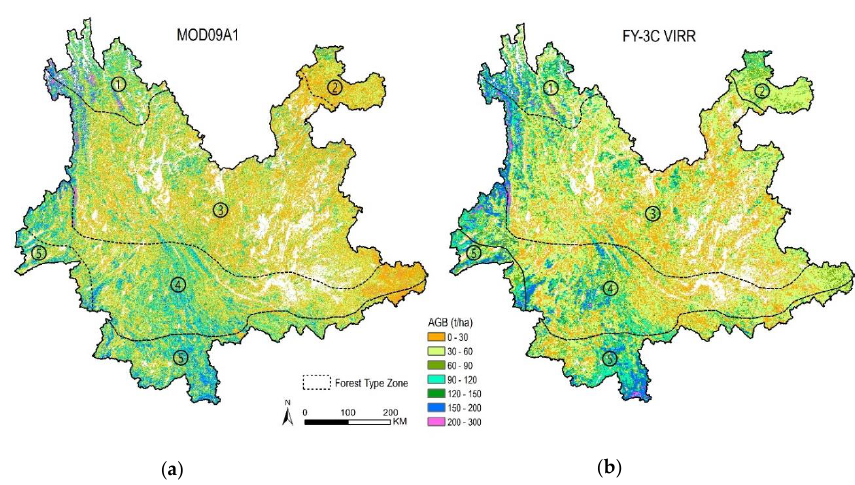
Figure 7. Forest AGB maps derived from ( a ) MOD09A1 and ( b ) FY-3C imageries based on RF models. Forest type zones: 1 (cid:13) cold-temperate coniferous forest, 2 (cid:13) warm evergreen broadleaved forest, 3 (cid:13) warm evergreen broadleaved and coniferous forest, 4 (cid:13) warm–hot broadleaved and coniferous forest and 5 (cid:13) tropical broadleaved The total forest AGB in Yunnan Province is 2123.22 Mt, with a mean value of 58.05 t/ha. The cold-temperate coniferous forest zone in the northwest has the highest mean forest AGB density, 76.08 t/ha, followed by the tropical broadleaved forest zone at 75.40 t/ha. These two forest zones contribute 8.39% and 18.08% of the total forest AGB of Yun- nan Province, respectively. The lowest mean forest AGB density (43.52 t/ha) occurs in the